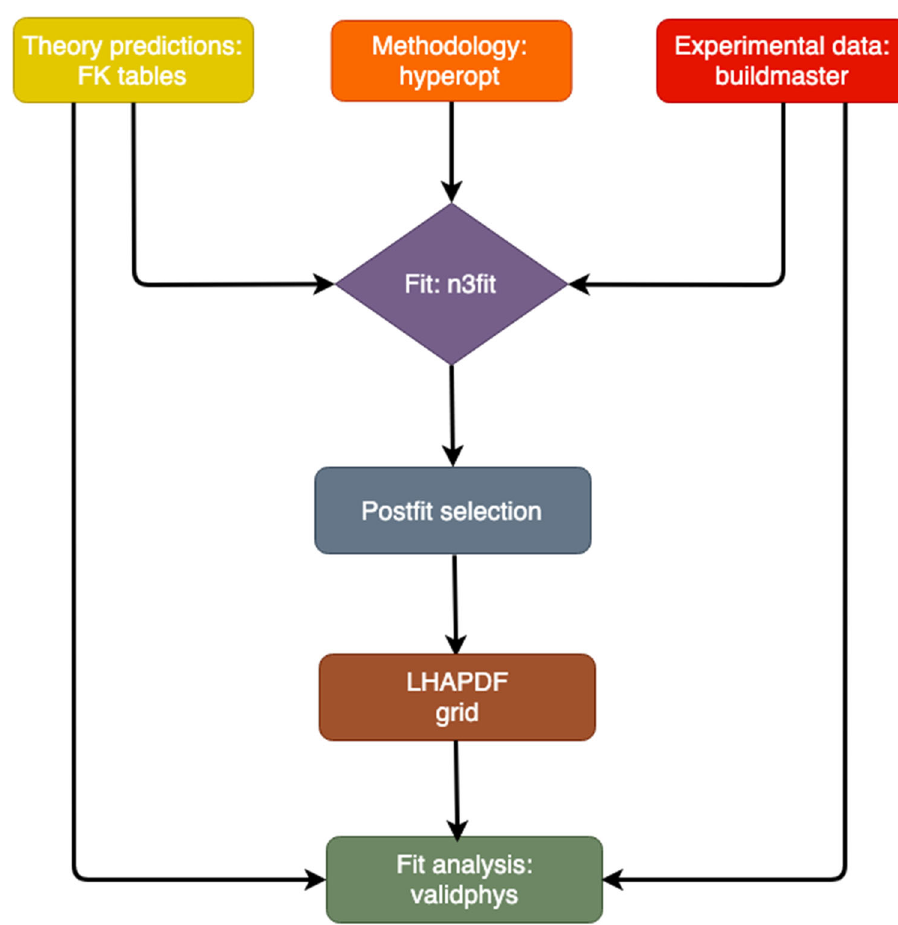
Fig. 1 Schematic of the NNPDF code. The three main inputs are the theoretical calculations, encoded in terms of the precomputed FK -tables, the methodological settings as determined by the hyperopt procedure, and the experimental data in the common buildmaster format. The PDFs are fitted using n3fit